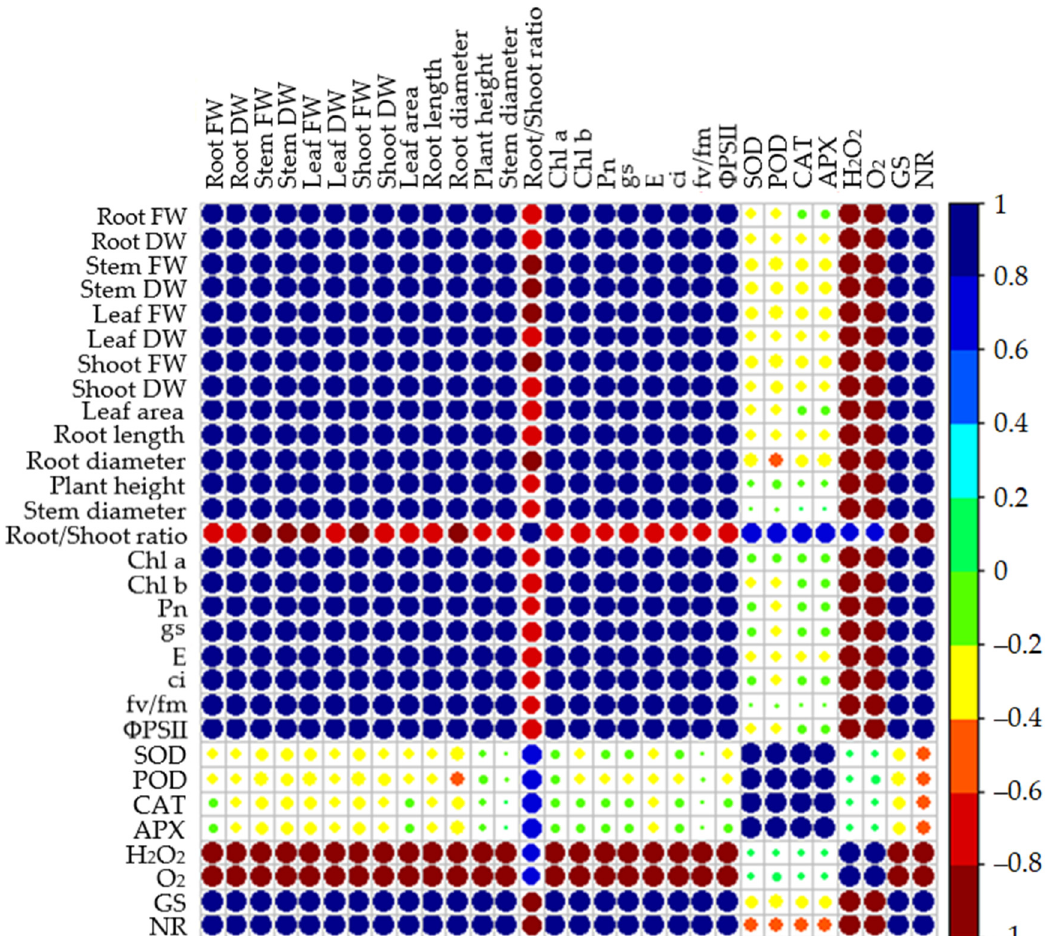
Figure 7. Correlation analyses of the inspected parameters of maize seedlings under drought-stress conditions in combination with melatonin in different levels of nitrogen. Root fresh weight (Root FW), root dry weight (Root DW), stem fresh weight (Stem FW), stem dry weight (Stem DW), leaf fresh weight (Leaf FW), leaf dry weight (Leaf DW), leaf area, root length, root diameter, plant height, stem diameter, root-to-shoot ratio, chlorophyll a,b (Chl a,b), net photosynthetic rate (gs), intercellular CO 2 (Ci), stomatal conductance (gs), and transpiration rate (E), maximal quantum efficiency of PSII photochemistry (Fv/Fm), the effective quantum yield of PSII photochemistry ( Φ PSII), superoxide dismutase (SOD), peroxidase (POD), catalase (CAT), ascorbate peroxidase (APX), hydrogen peroxide (H 2 O 2 ) superoxide (O 2 ), glutamine synthetase (GS), and nitrate reducates (NR) activities. Different colours on the scale from green to dark blue indicate positive correlation while light green to dark red indicate negative correlation.